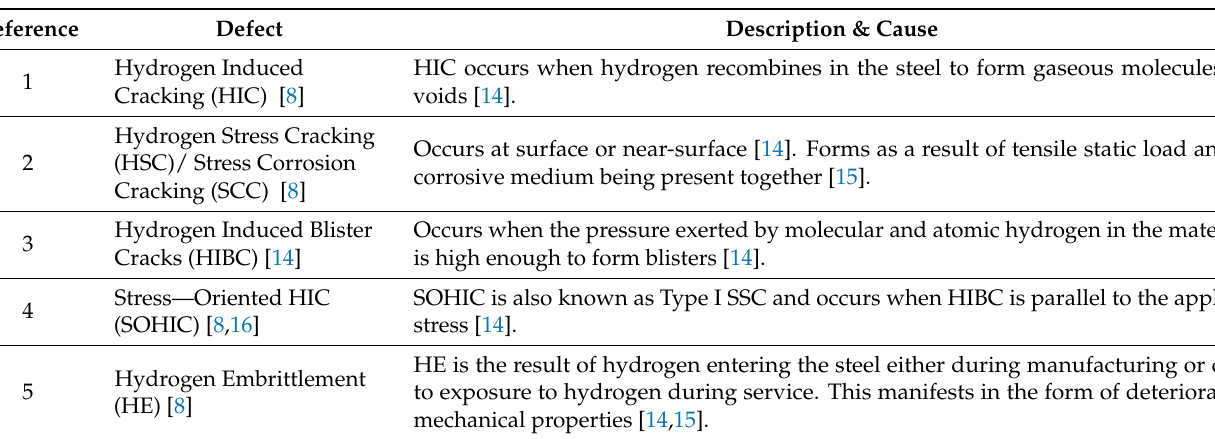
Figure 1. A summary of the types of hydrogen damage seen in pipeline steel. Table 1. The defects caused by hydrogen in pipeline steels and their